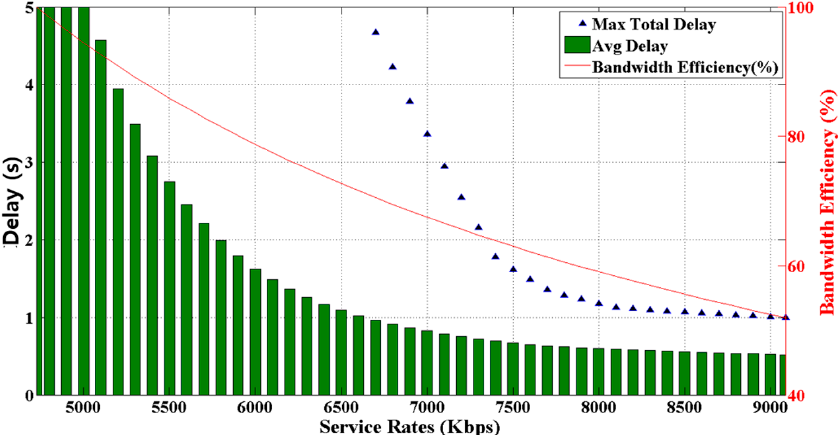
Figure 4. Simulation results of ‘Big Buck Bunny’. Table 4. Simulation results of ‘Big Buck